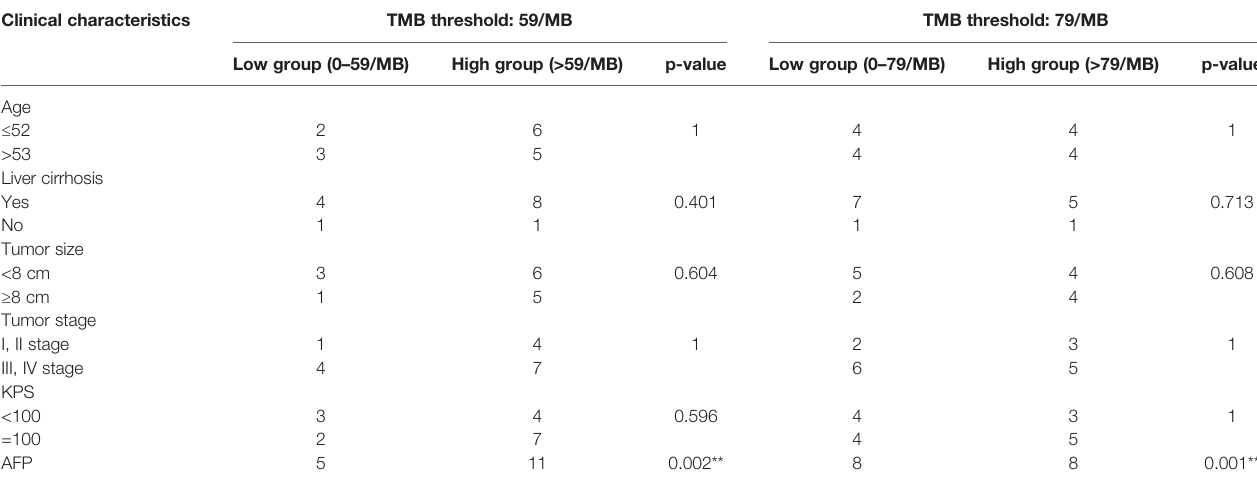
TABLE 3 | Correlation between TMB and clinicopathological parameters (p-value). Clinical